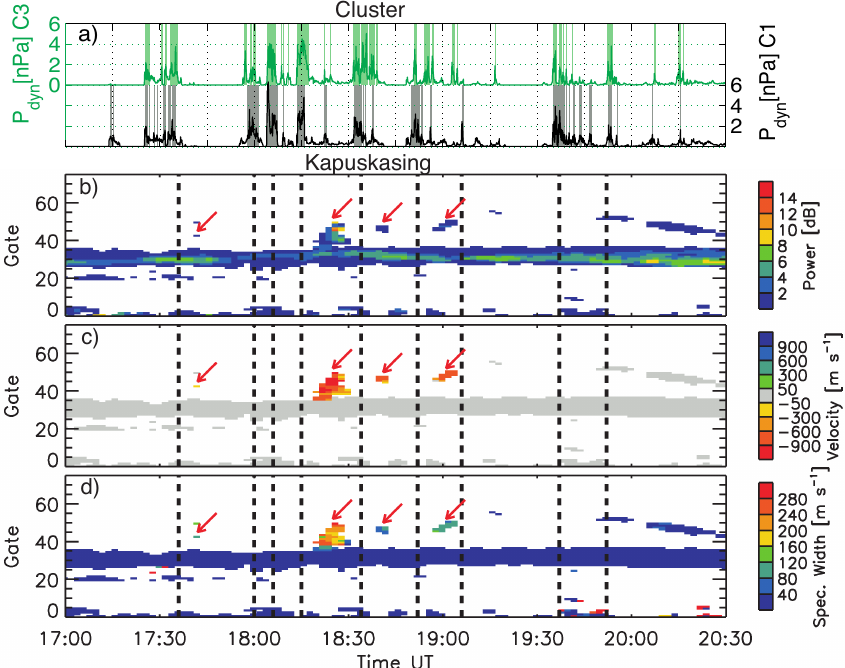
Fig. 9. (a) C1 (black) and C3 (green) magnetosheath dynamic pressure observations. The intervals when the local dynamic pressure exceeded the solar wind dynamic pressure are shaded. Lower panels: SuperDARN Kapuskasing radar observations. The panels show range-time plots of (b) backscattered power, (c) ionospheric velocity and (d) spectral width measured along beam 8 of the radar. The data have been median-filtered to remove salt-and-pepper noise. Vertical dashed lines mark the nine main supermagnetosonic jets observed by C1. The red arrows identify enhanced ionospheric flows.